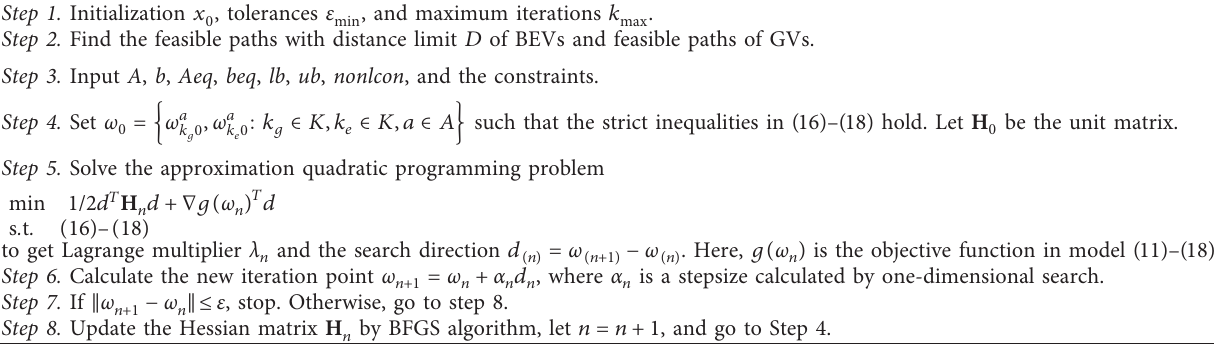
Table 1: Algorithm frame.